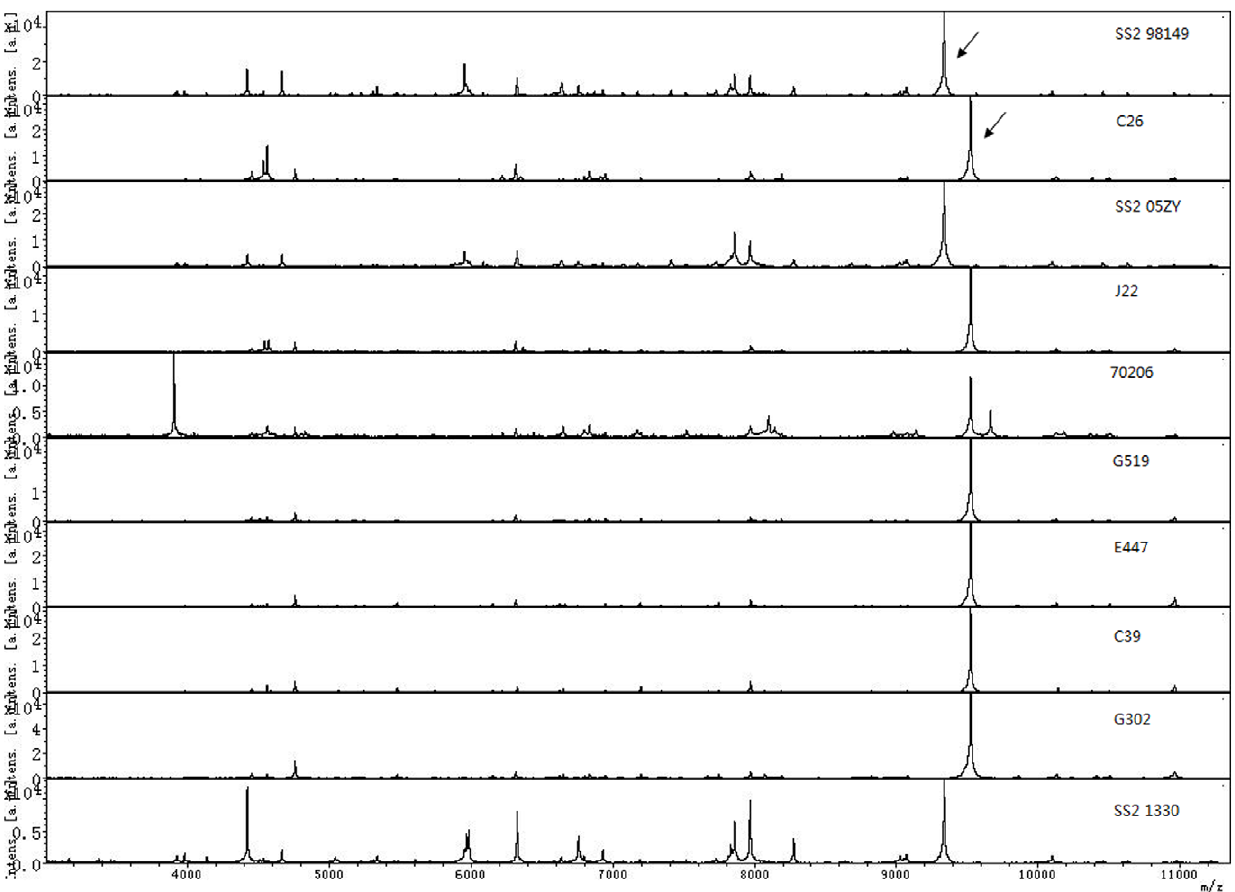
Figure 1. The spectra obtained from 7 GAS and 3 SS2 isolates. The peak lists of three SS2 isolates (SS2 98149, SS2 05ZY and SS2 1330) and seven GAS isolates (C26, J22, 70206, G519, E447, C39 and G302). The peaks at m/z 9378.27 and m/z 9789.30 were special to SS2 and GAS, respectively. All the isolates were confirmed by genome sequence or specific gene PCR.